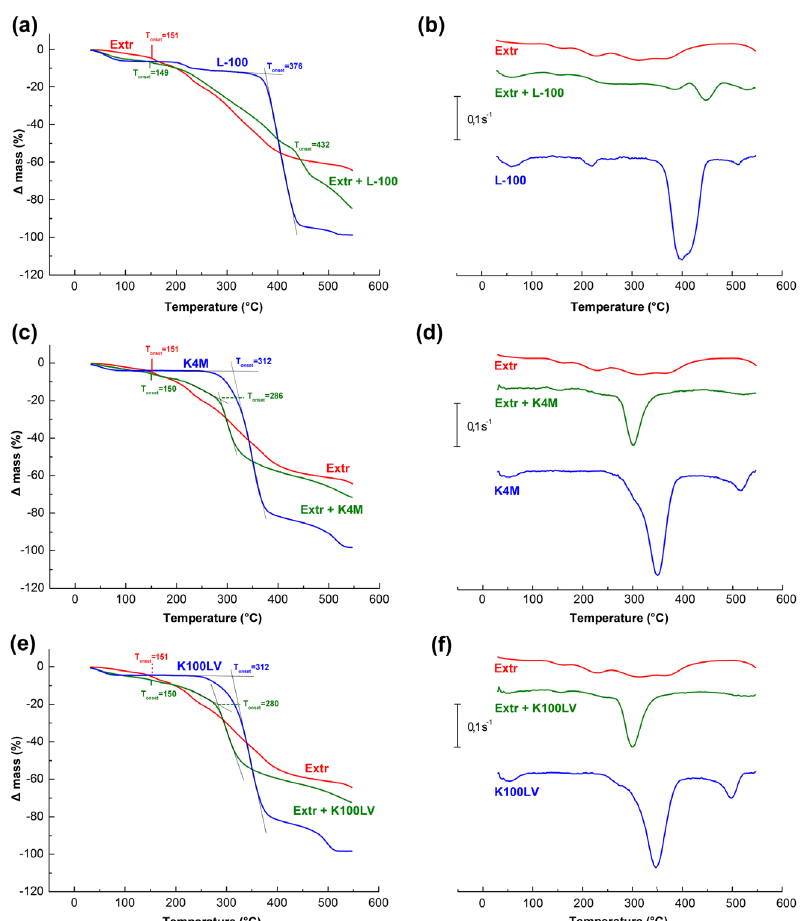
FIGURE 2 – TG and DTG curves of the bilberry leaf powder extract (Extr), the individual excipient and their binary mixture (1:1 mass ratio): Eudragit L100 (L-100) (a, b), Methocel K4M (K4M) (c, d), and Methocel K100LV (K100LV) (e,